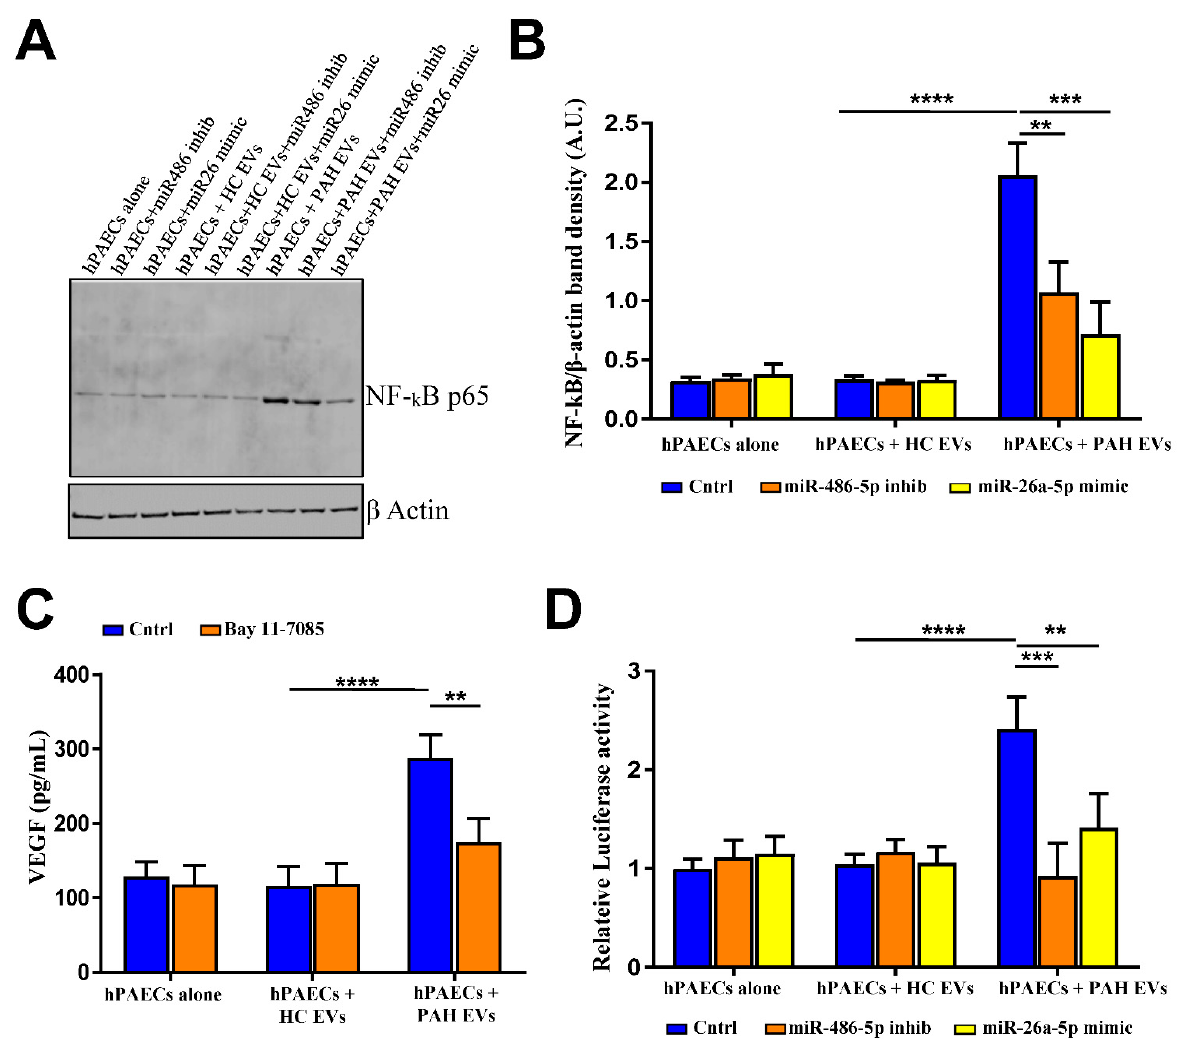
Figure 5. ( A ) Representative immunoblot of NF-kB p65 from hPAECs lysate that was incubated with either HC or PAH EVs followed by miR inhibitor or mimic transfection. ( n = 3). ( B ) Densitometric quantitation of NF-kB band intensity from blots from 5A. Data are presented as ratios of band densities of NF-kB to b-actin in arbitrary units (A.U.) from three independent experiments and given as mean with SD. ( C ) ELISA analysis to detect the concentrations of proangiogenic VEGF-A in hPAEC culture supernatant pre-incubated with EVs in the presence or absence of NF-kB inhibitor (Bay 11-7085; 50 nM for 24 h). Results are from n = 3 biological replicates and indicated as mean value with SD. ( D ) Luciferase reporter quantification of NFkB activation in hPAECs was done in double transfected cells that were pre-incubated or not with EVs prior to mock, miR inhibitor,